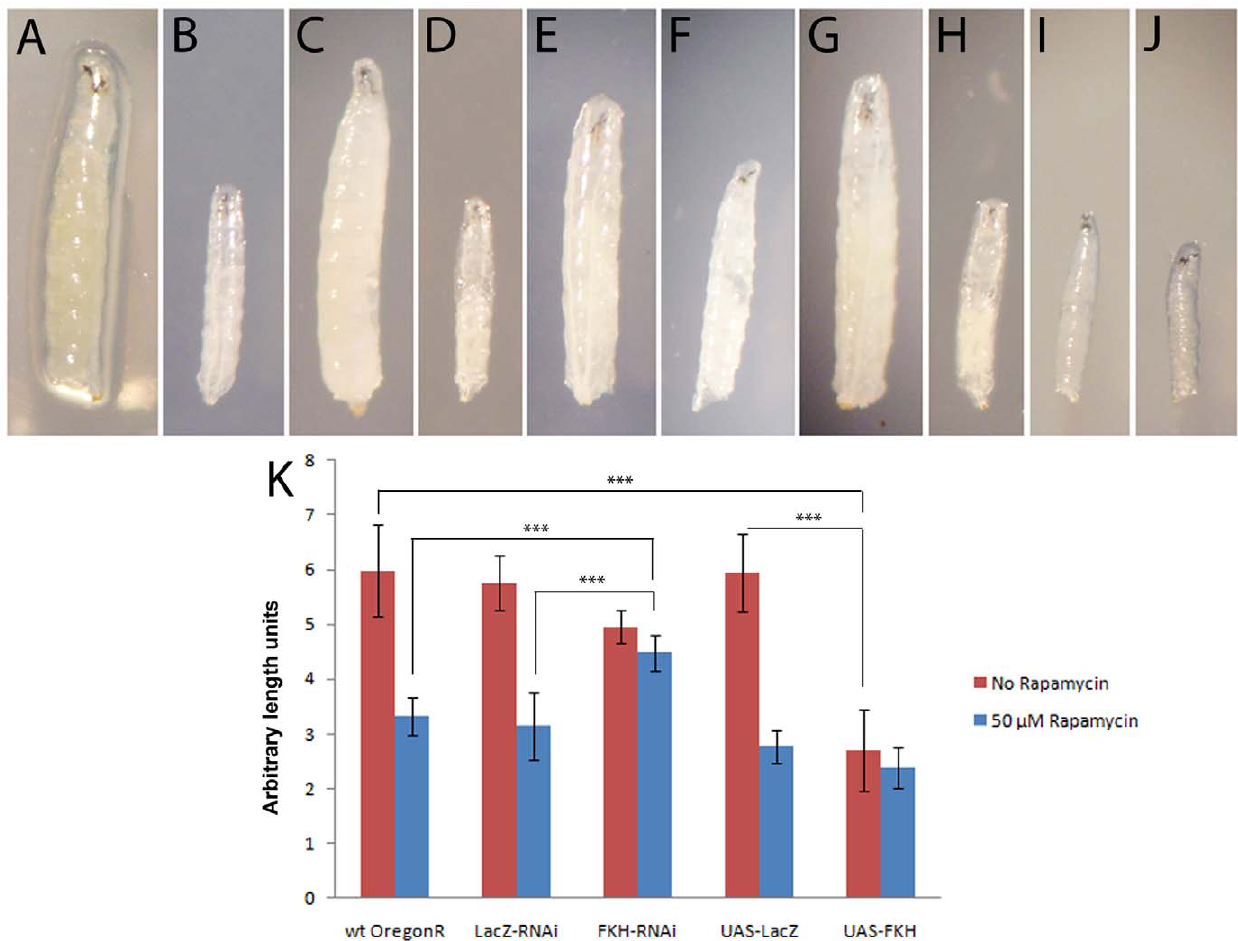
Figure 1. FKH levels influence larval body size. Pictures show 72 h old larvae ( 6 2h) which were treated at 24 h after egg deposition (AED) with 0 ( A , C , E , G , I ) or 50 m M ( B , D , F , H , J ) rapamycin for 48 h. A, B: OregonR wildtype control. C, D: y w UAS-LacZ-RNAi ; arm-Gal4/ + . Treating control larvae with 50 m M rapamycin leads to severe reduction of growth. E, F: w; arm-Gal4/ + ; UAS-FKH-RNAi/ + . Untreated larvae are slightly smaller than controls, but size reduction by rapamycin feeding is less pronounced in larvae with low FKH levels. G, H: w;; ppl-Gal4/UAS-LacZ . I, J: w;; ppl-Gal4/UAS- FKH . Overexpression of FKH leads to a severe reduction in body size similar to that resulting from rapamycin feeding. At 25 u C, overexpression furthermore leads to larval lethality in the 2 nd instar. Rapamycin feeding of FKH-overexpressing larvae has almost no additive effect to the reduction in body size. ( K ) Quantitation of larval body size shows that rapamycin-treated larvae with low FKH levels are significantly larger than control larvae and that untreated larvae with high FKH levels are significantly smaller than control larvae. Significance was tested using an unpaired 2-tailed Student’s t-test. ***=p , 0.001. Error bars represent standard error of the mean (SEM).